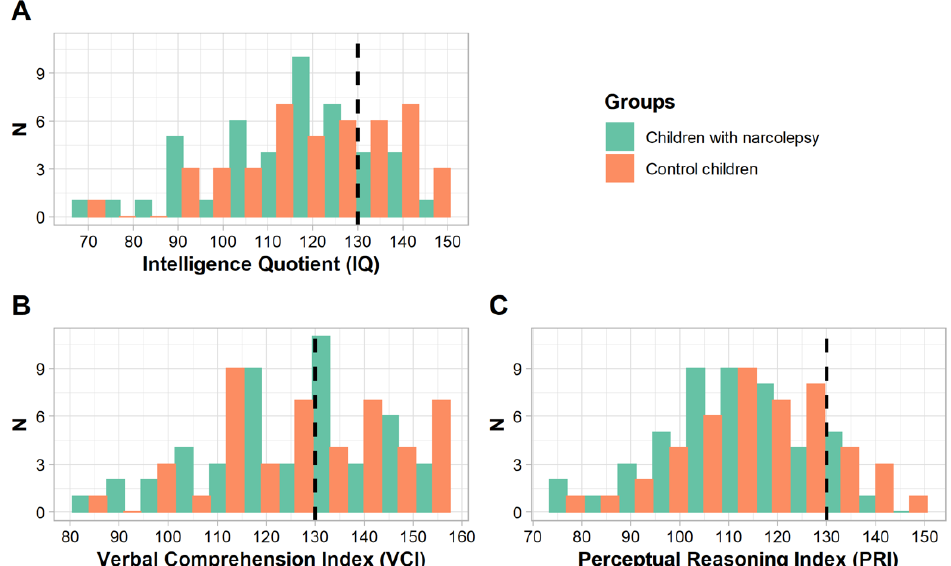
Figure 1. Histograms of the Weschler Intelligence Scale for Children (WISC) scores (( A ) Intellectual Quotient; ( B ) Verbal Comprehension Index; ( C ) Perceptual Reasoning Index) in children with nar- colepsy (green) and in control children (orange). The dashed lines represent the threshold scores for the area of high intellectual potential.